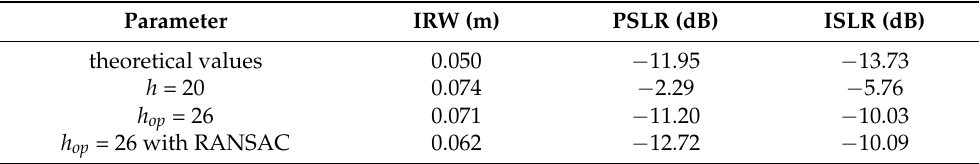
Table 5. Quality evaluation table of multi-component